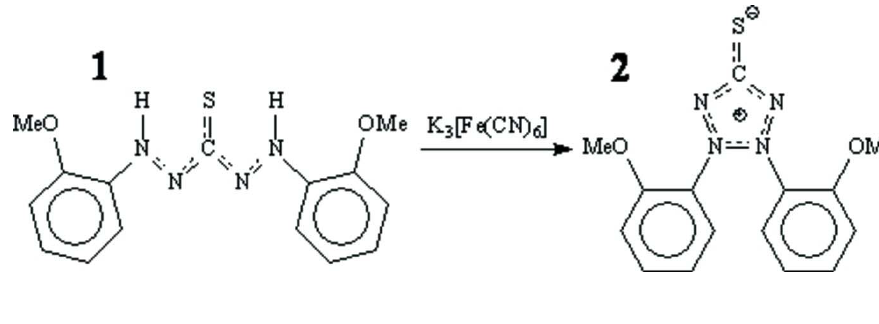
The formation of the title